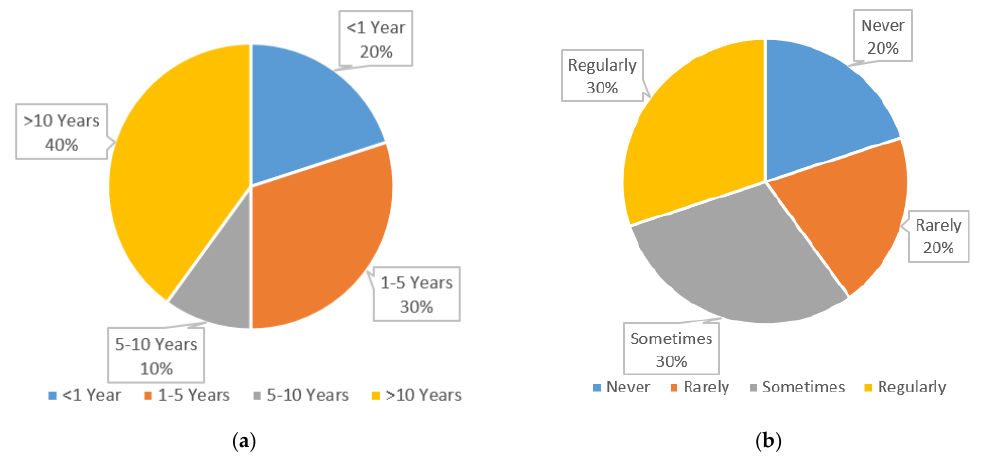
Figure 12. ( a ) Participant’s experience over lectures/presentations. ( b ) Use of a board during